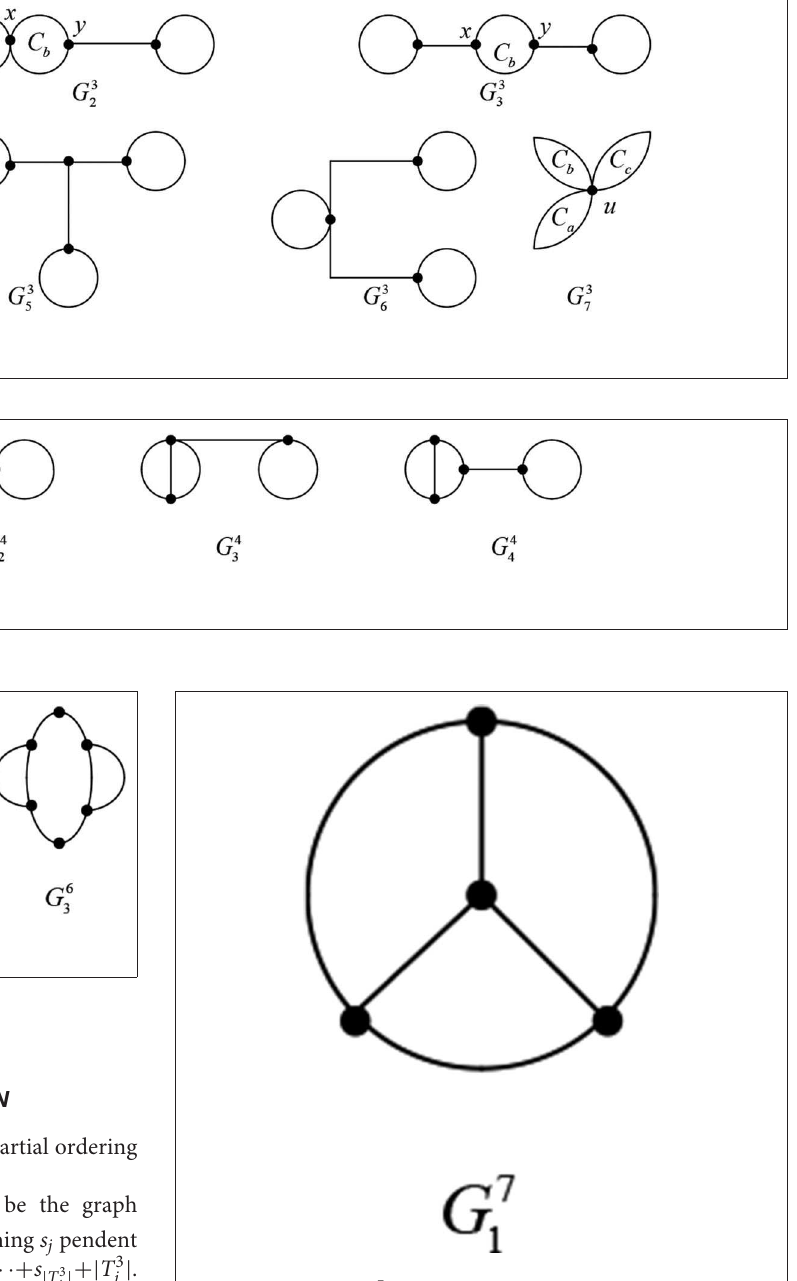
FIGURE 4 | The graph G 7 1